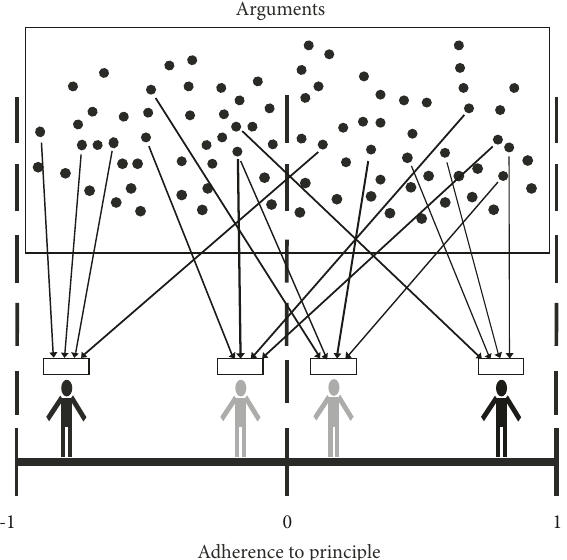
Figure 2: Representation of agents and their arguments on the opinion or adherence to the principles spectrum. The rectangles on the agents are their argument sacks. Arguments are depicted by dots and arrows from the arguments to the sacks depict both the arguments they hold in the opinion spectrum and the number of arguments they hold: 𝑘 𝑖 = 4 and 𝜙 𝑒 𝑖 = 0.75 , and 𝜙 𝑚 𝑖 = 0.5 for all agent 𝑖